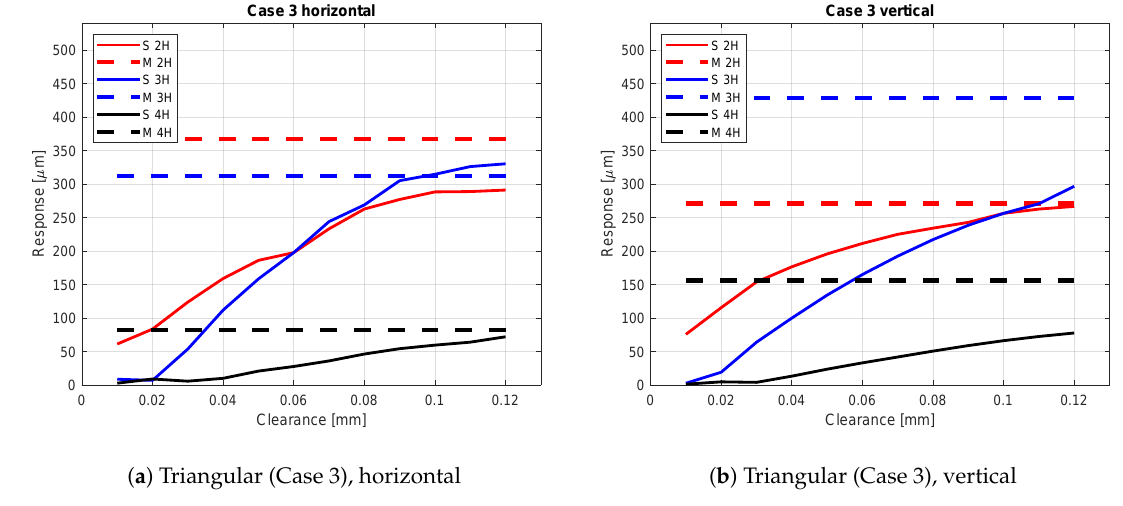
Figure 13. Case 3—triangular bearing inner ring roundness profile in the service end.